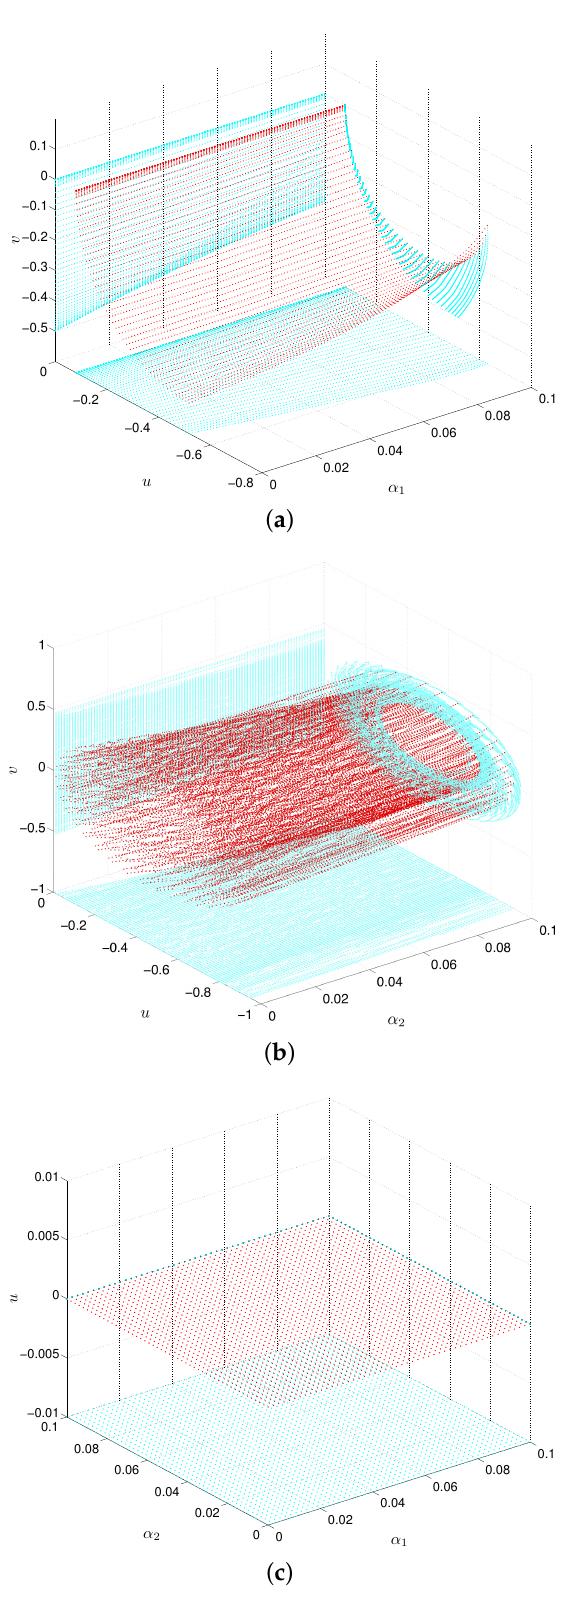
Figure 5. ( a – c ) Bifurcation diagrams of oblateness coefficient of the i th ( i = 1,2) primary in the frames α 1 uv , α 2 uv and α 1 α 2 u , respectively, when κ = 1, µ m = 0.48785, q 1 = 0.9988, q 2 = 0.9985, α = 1.001, β =